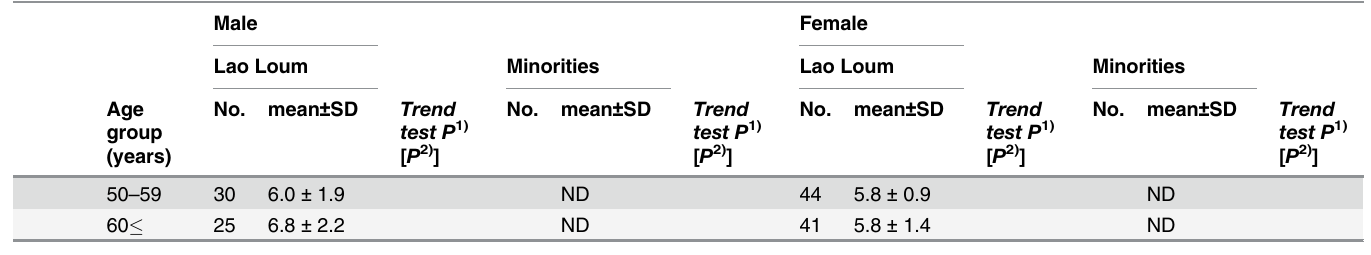
Table 4 shows a comparison of anthropometric and clinical characteristics data collected at the beginning and end of a 5-year period from Lao Loum subjects. Body weight, BMI, WC increased significantly in males ( P = 0.010, 0.009, 0.037, respectively) and females ( P < 0.001, < 0.001, < 0.001, respectively). Height, SBP, and DBP remained similar in both males and females. Resting HR increased significantly in males ( P = 0.049) and trended toward an increase in females ( P = 0.056). Blood glucose also significantly increased in both males ( P = 0.044) and females ( P = 0.002). HbA1c increased only in females ( P < 0.001), but not in males ( P = 0.172).